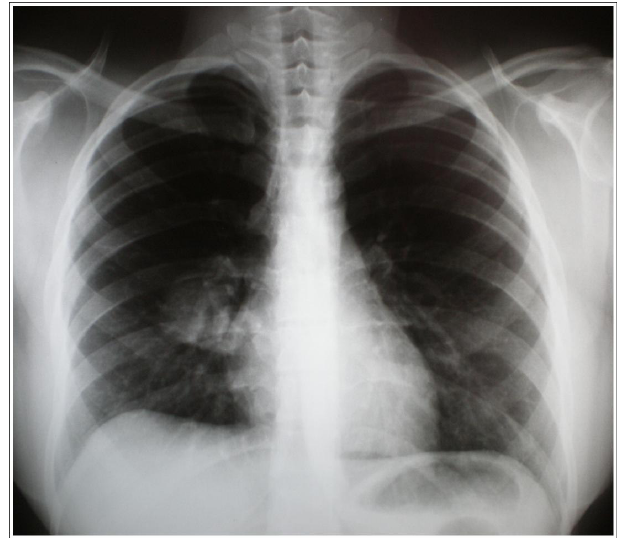
FIGURE 1. Chest X-ray film showing a 4-cm parahilar opacity.